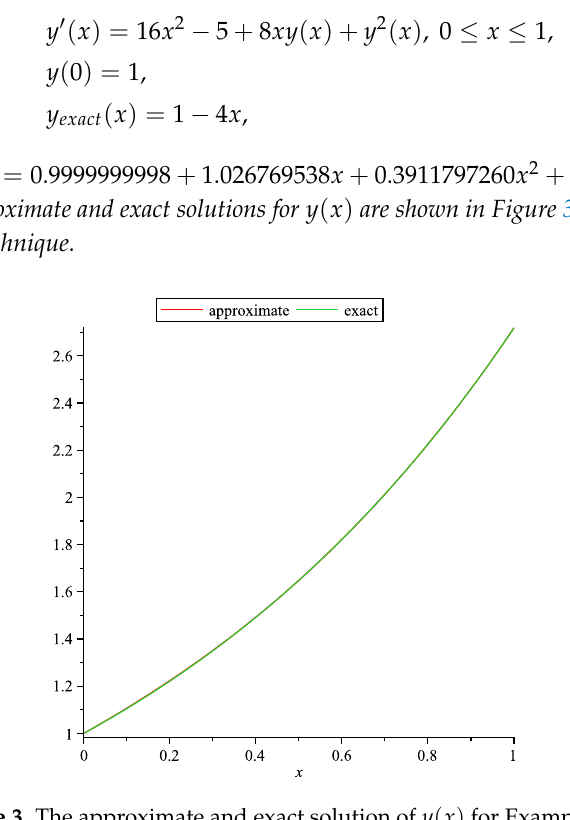
Figure 3. The approximate and exact solution of y ( x ) for Example 3. Table 3. The absolute error of the this method for Example